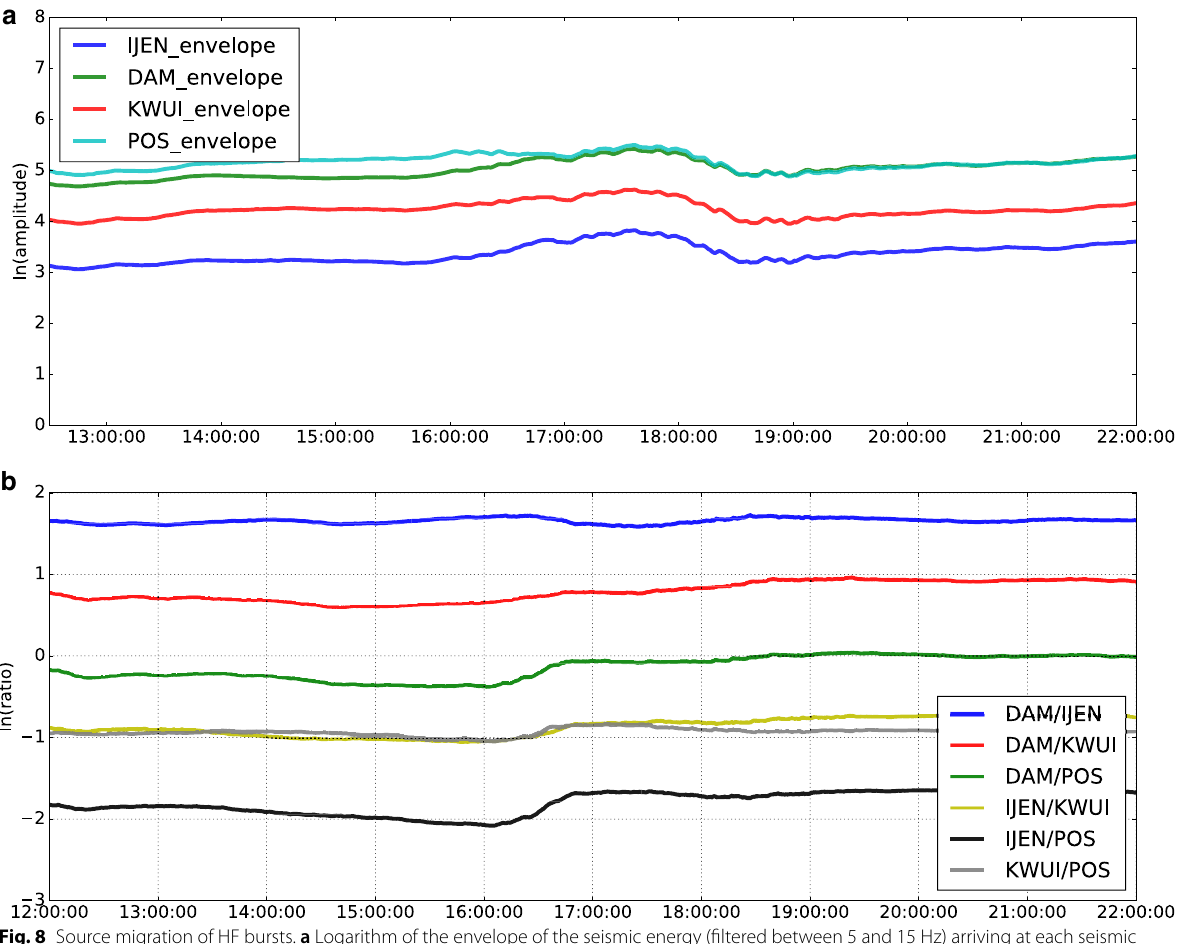
Fig. 8 Source migration of HF bursts. a Logarithm of the envelope of the seismic energy (filtered between 5 and 15 Hz) arriving at each seismic stations. Data are smoothed using a 10 min sliding median filter. b Ratios of seismic energy, station 1 / station 2 , recorded across the network. Considering vertical or horizontal migration, an increase in this ratio corresponds to a source getting closer to station 1 , while a decrease correspond to a source getting closer to station 2 , see text for more